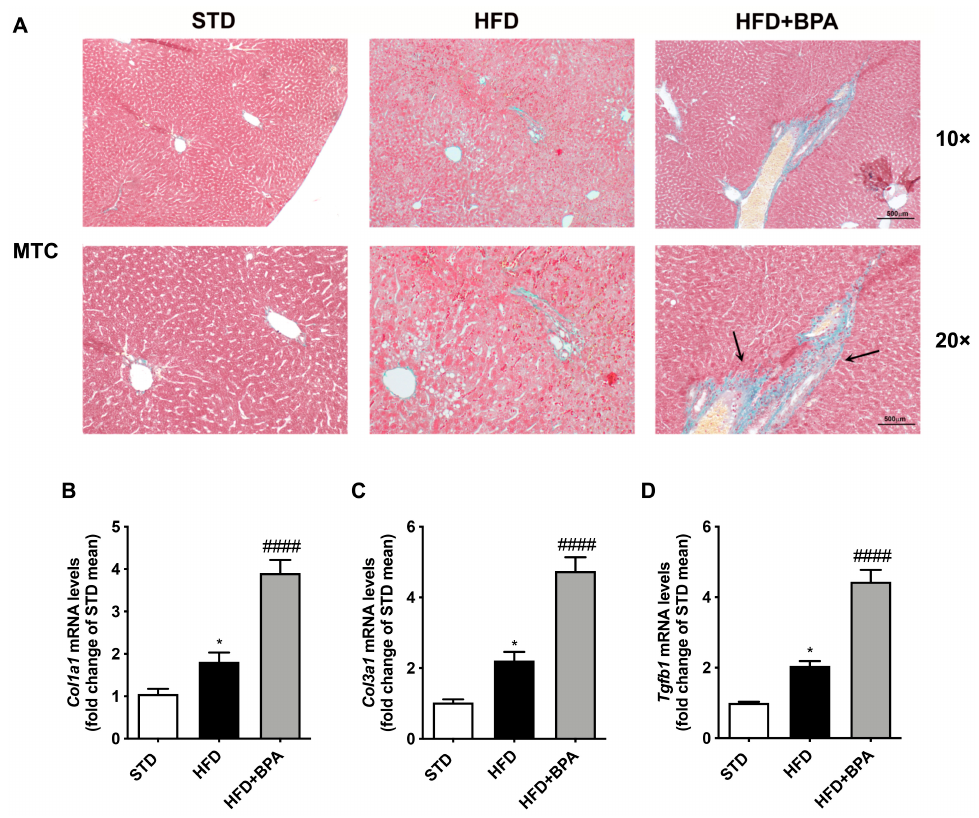
Figure 5. BPA exposure promotes liver fibrosis progression in HFD-fed mice. ( A ) Mallory trichrome (MTC) staining was assessed to determine the fibrotic lesions induced by BPA on the liver from HFD mice ( n = 4 each group). Gene expression of pro-fibrotic ( B – D ) Col1a1 , Col3a1 , and Tgfb was determined by real-time PCR analysis. Data are presented as means ± SEM of all animals ( n = 6 each group) (* p < 0.05 vs. STD; #### p < 0.0001 vs.